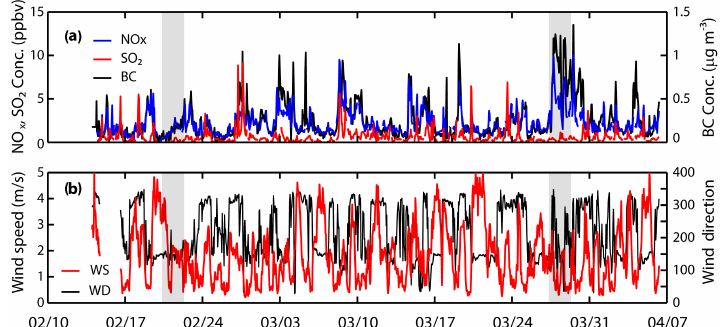
Figure 7. Measurements during the first study period (February–April 2013) at THRO-N of hourly averaged (a) NO x (blue), SO 2 (red), and BC (black); and (b) wind speed (red) and wind direction (black). Shaded areas indicate time periods discussed in the text and shown in Fig. 6.